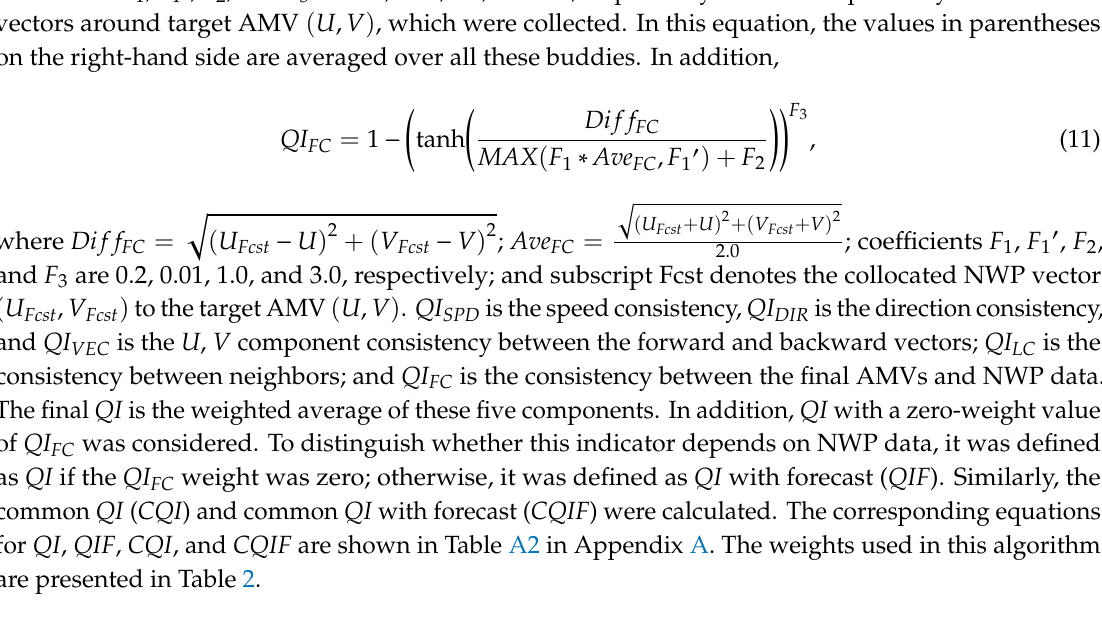
Table 2. The weights used in this algorithm for QI, QI with forecast (QIF), common QI (CQI), and CQI with forecast (CQIF). W SPD , W DIR , W VEC , W LC , and W FC represent the weights of the speed, direction, vector, first-guess, and spatial consistencies, respectively. W SPD W DIR W VEC W